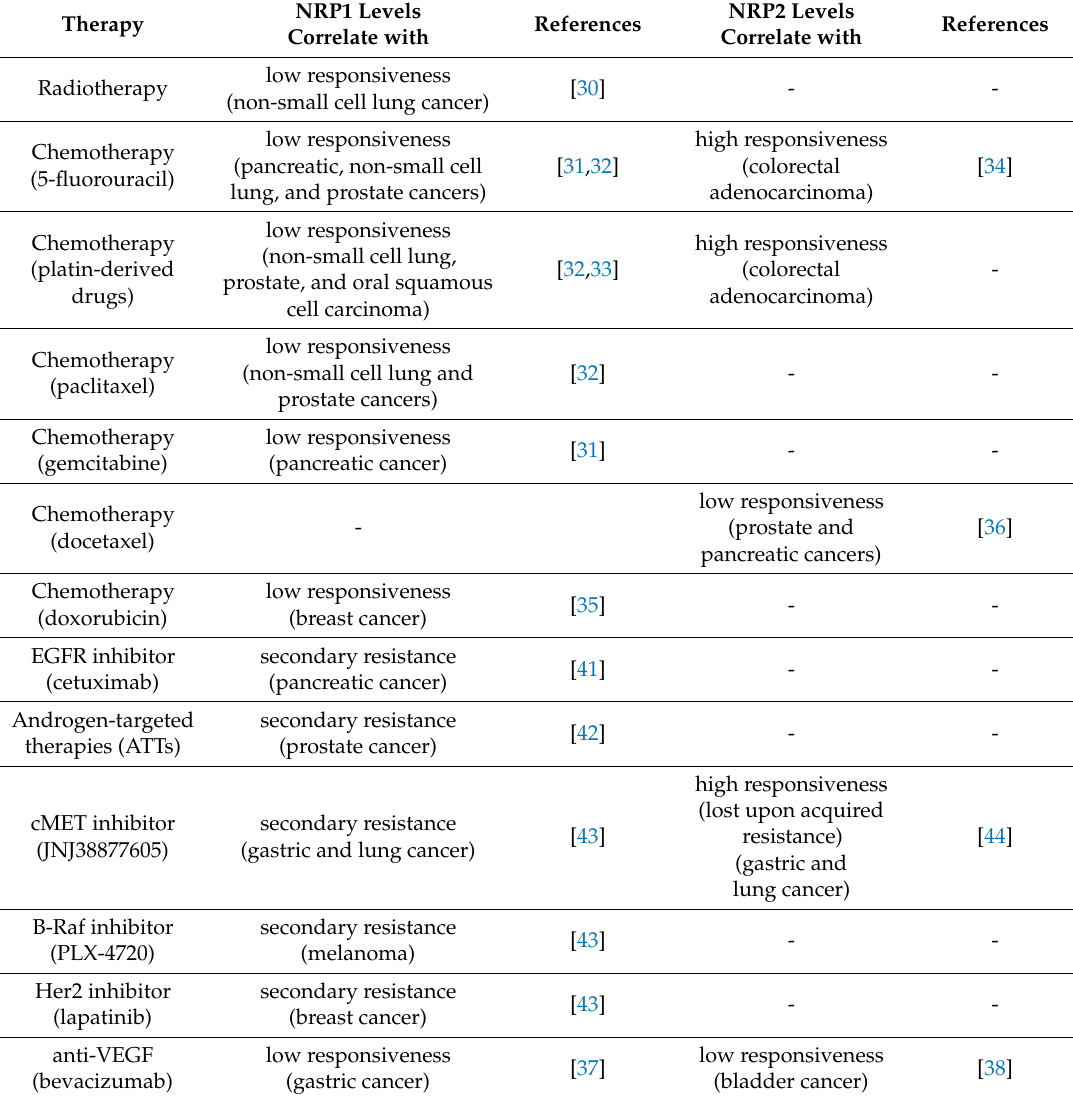
Table 1 lists reported correlations between high expression levels of NRP1 or NRP2 and responsiveness or resistance to di ff erent kinds of cancer therapies. Tumor samples derived from treated patients were analyzed in part of the studies (by immunohistochemistry or mRNA qPCR); in other cases, gene expression was engineered in cultured cancer cells subjected to therapy. In parentheses, the implicated drugs (in first column) and tumor types (in second and fourth column) are specified; “-“ stands for “not